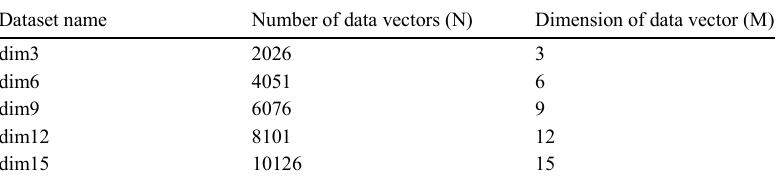
Table 1. Summary of the Dim-sets